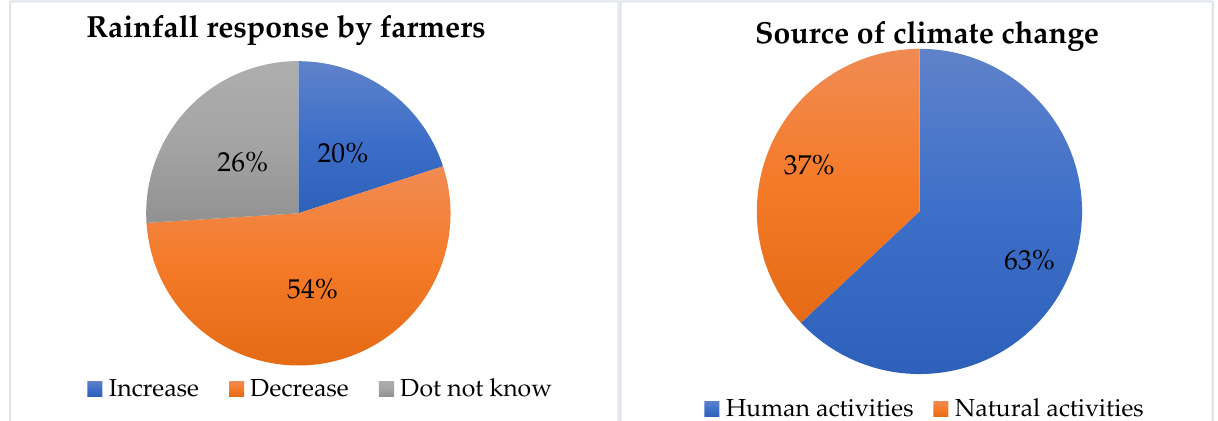
Figure 3. Perceptions of farmers about the reason for climate change and rainfall.